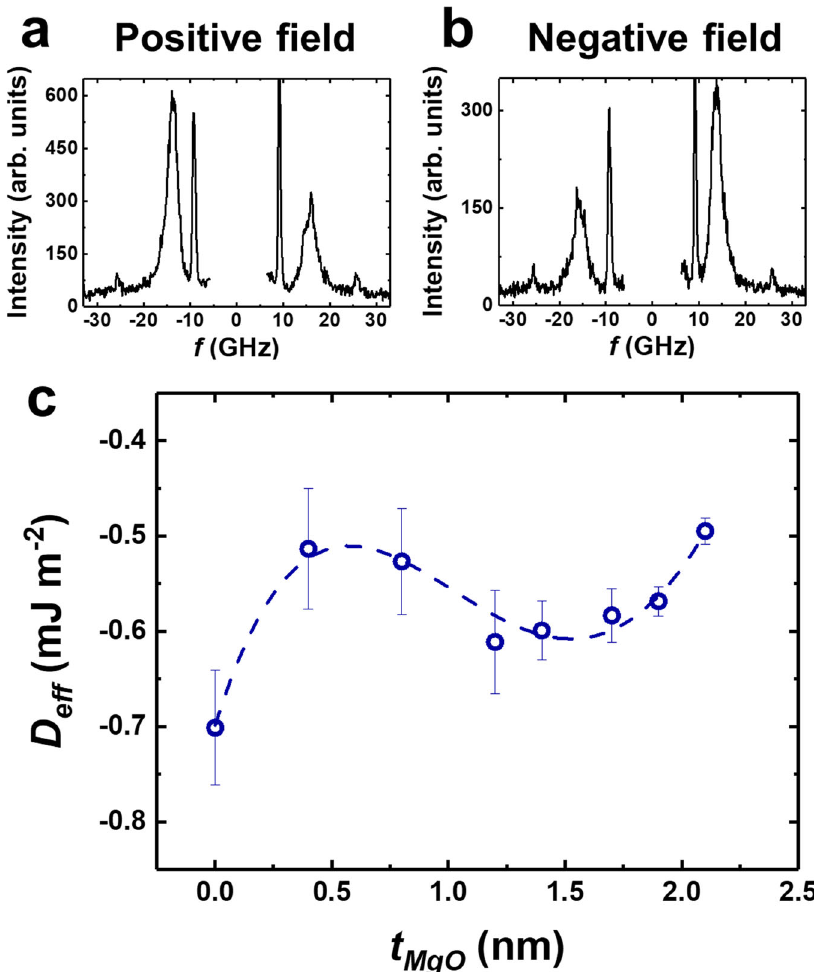
Fig. 2 Measured BLS spectra of Ta(3)/Pt(5)/MgO( t MgO )/CoFeSiB(0.9)/MgO(1)/Ta(2). a , b BLS spectrum signal recorded at k sw = 22 µ m − 1 ( θ = 60 ˚ ) with a positive (negative) saturating fi eld of + 400 mT ( − 400 mT) for a sample with t MgO = 2.1 nm. c Effective iDMI energy density as a function of t MgO . Oscillating-like behavior of the iDMI energy density as a function of t MgO for Ta(3)/Pt(5)/MgO( t MgO )/CoFeSiB(0.9)/MgO(1)/Ta(2). Error bars represent standard deviation, n = 2 independent